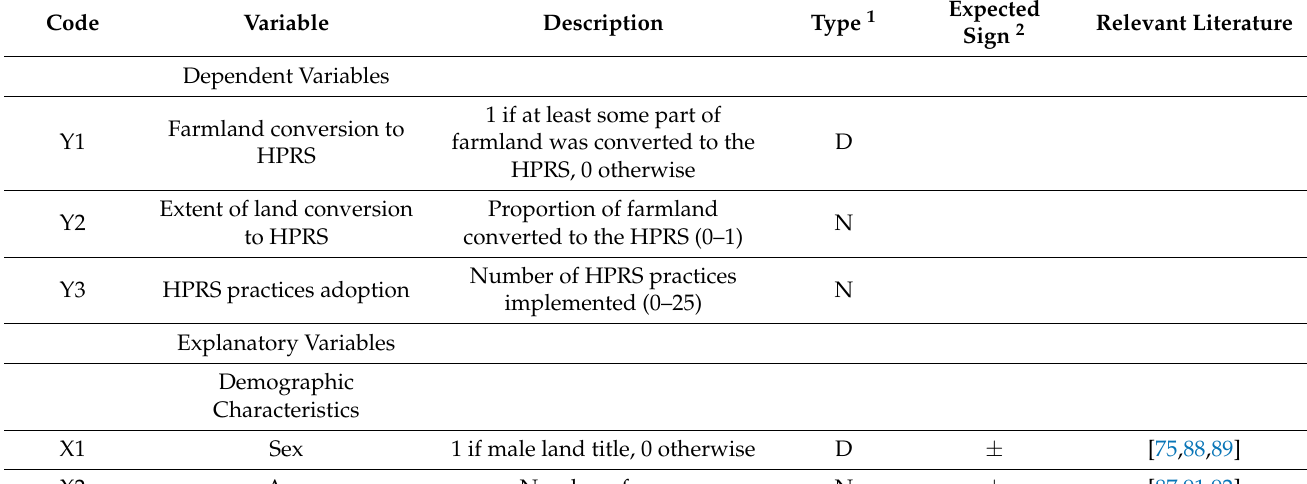
Table 4. Variables included in the three regression models in assessing the factors associated with the adoption of the Hill Pond Rice System (HPRS) in northern